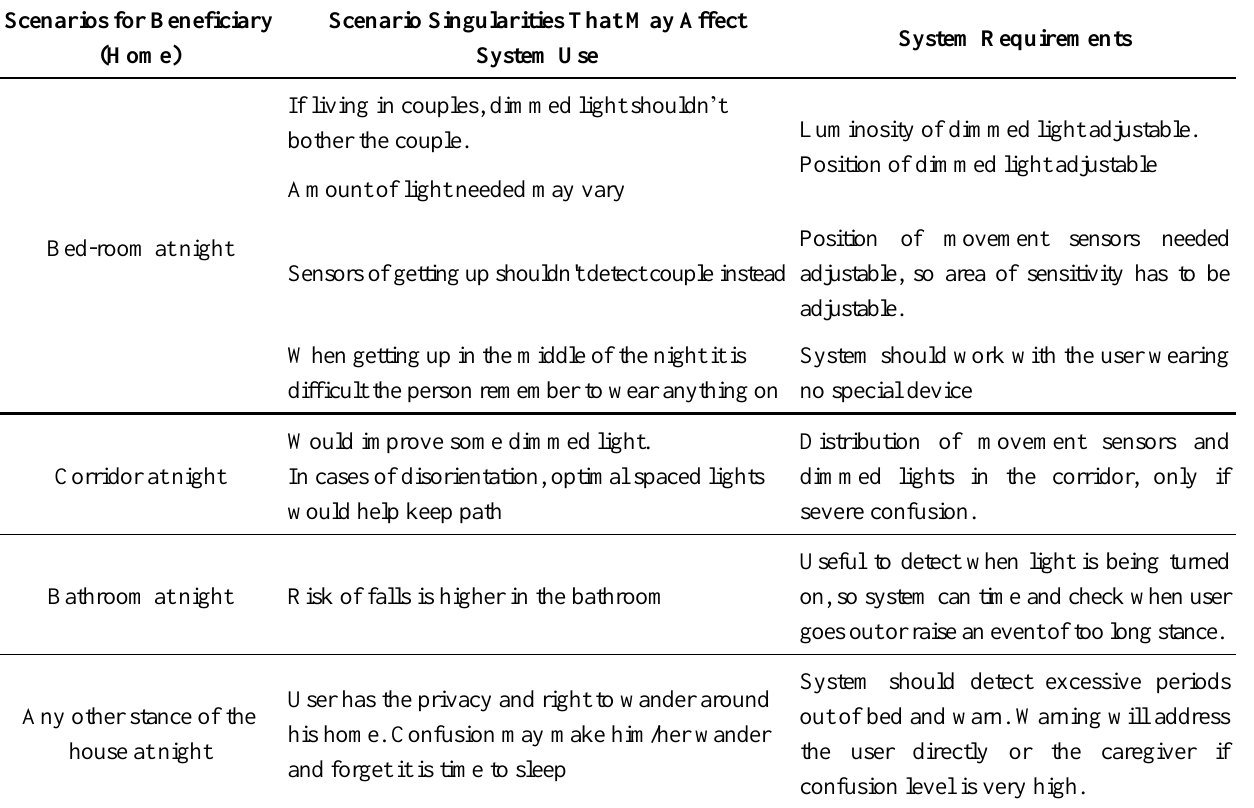
Table 6. Analysis of user needs and system requirements regarding